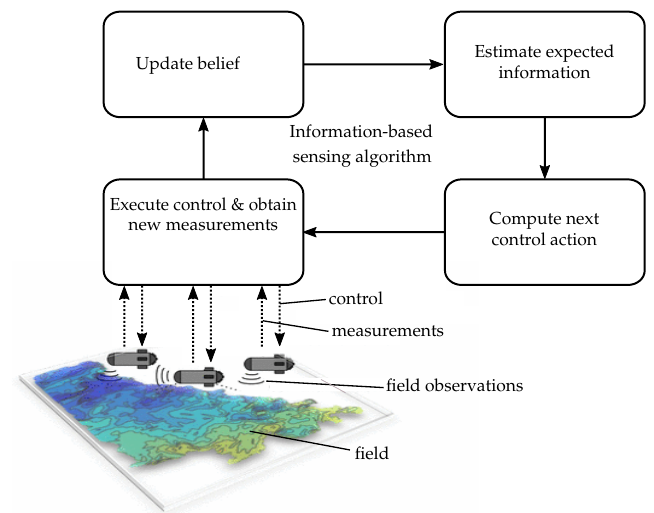
Figure 2. Components of a closed-loop, information-based sensing algorithm for field exploration with autonomous underwater